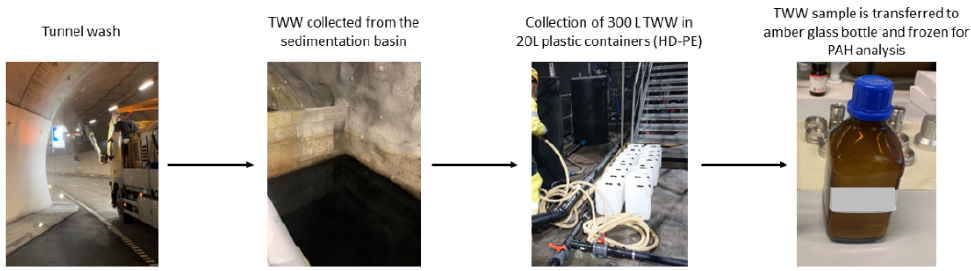
Figure 1. Schematic for sampling of tunnel wash water.